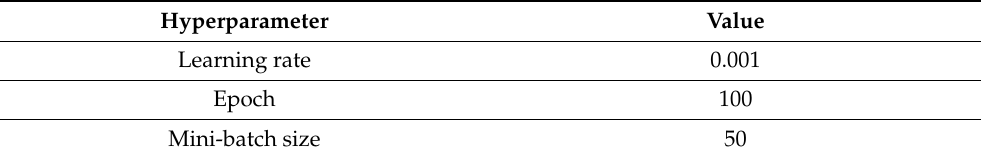
Table 3. Hyperparameters set up.